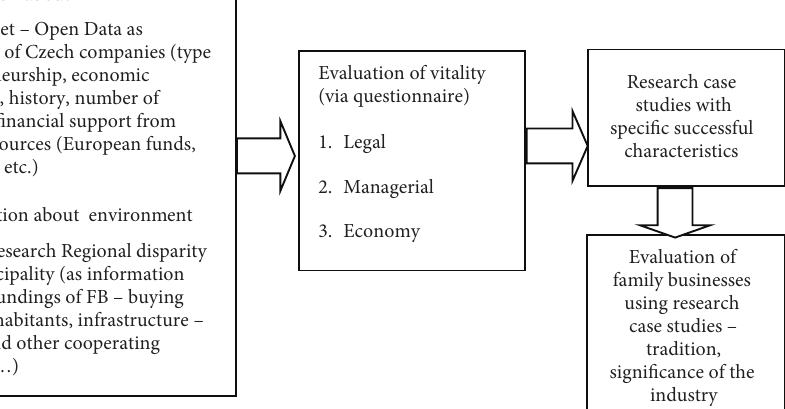
Figure 1. Scheme of the developed knowledge